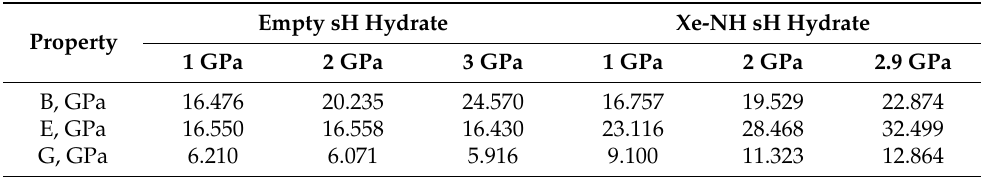
Figure 2. Pressure-dependent bulk (B), Young’s (E), and shear (G) moduli of CO 2 -NH sH gas hydrate at 0 K. Table 3. Properties of CO 2 -NH sH gas hydrate at 0 K and 0 GPa. Table 4. Bulk (B), Young’s (E), and shear (G) moduli of empty and Xe-NH sH gas hydrates under pressure and at 0